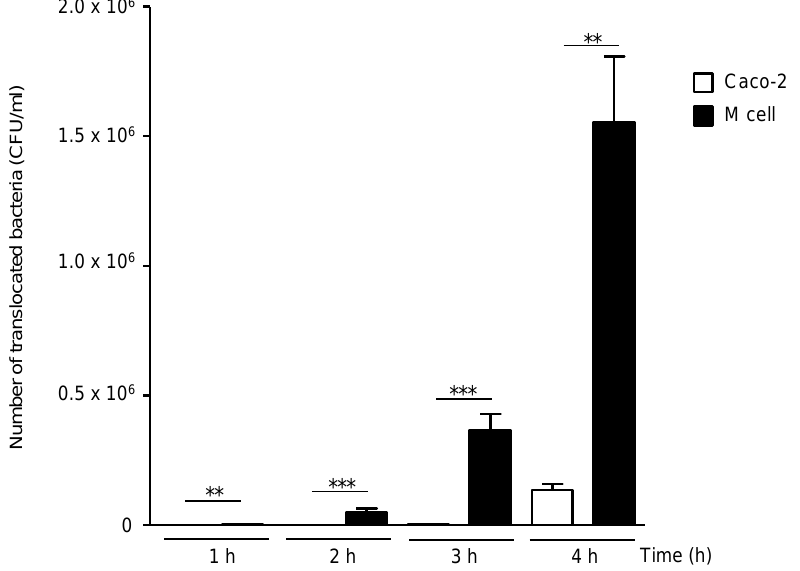
Figure 1. In vitro translocation of AIEC LF82 strain across human M-cell monolayers. A total of 1 × 10 7 LF82 bacteria were added into the apical compartment of the M-cell or the control Caco-2-cl1 monolayers. The number of translocated bacteria (CFU/mL) into the basolateral compartments of M-cell or Caco-2-cl1 monolayers at 1 to 4 h post-infection was determined. Results are means ± standard error of the mean (SEM) for replicate experiments. ** p ≤ 0.01 or *** p ≤ 0.001). Statistical analysis was performed using the non-parametric Kruskal–Wallis test with GraphPad Prism version 5.01 software (GraphPad Software, San Diego, CA,